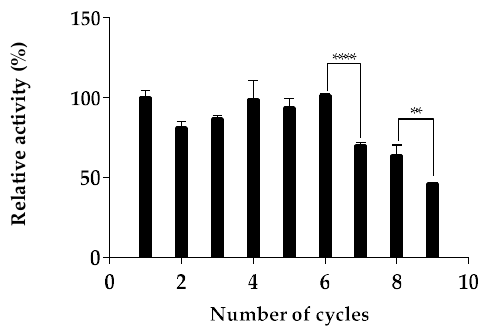
Figure 5. Recyclability test of endo-1,4-β-mannanase immobilised on chitosan using 0.5% ( w/v ) LBG as substrate (30 min, pH 5.0, 55 °C). Each value in the panel represents the means ± SD (n = 3). Relative absorbance (%) was used, with cycle 1 set as 100%. Key: **** ( p -value < 0.0001); **( p -value = 0.0096).